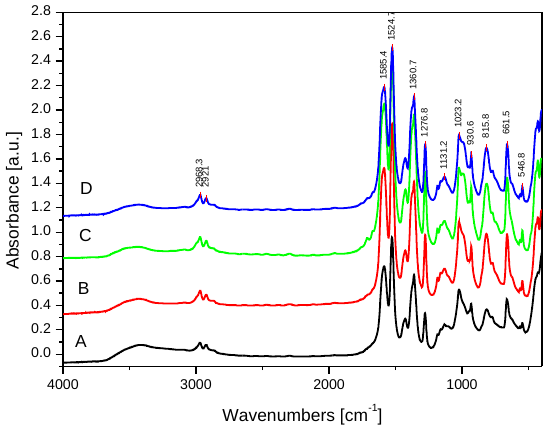
Figure 3. FTIR spectra of ST12 gel with different amount of vana- Fig.3. FTIR spectra of ST12 gel with different amount of vanadium (in relation to 1M Ti): dium (in relation to 1 M Ti): A = 0.02 M; B = 0.04 M; C = 0.06 M; D = 0.07 M. A = 0.02M; B = 0.04M; C = 0.06M; D = 0.07M.